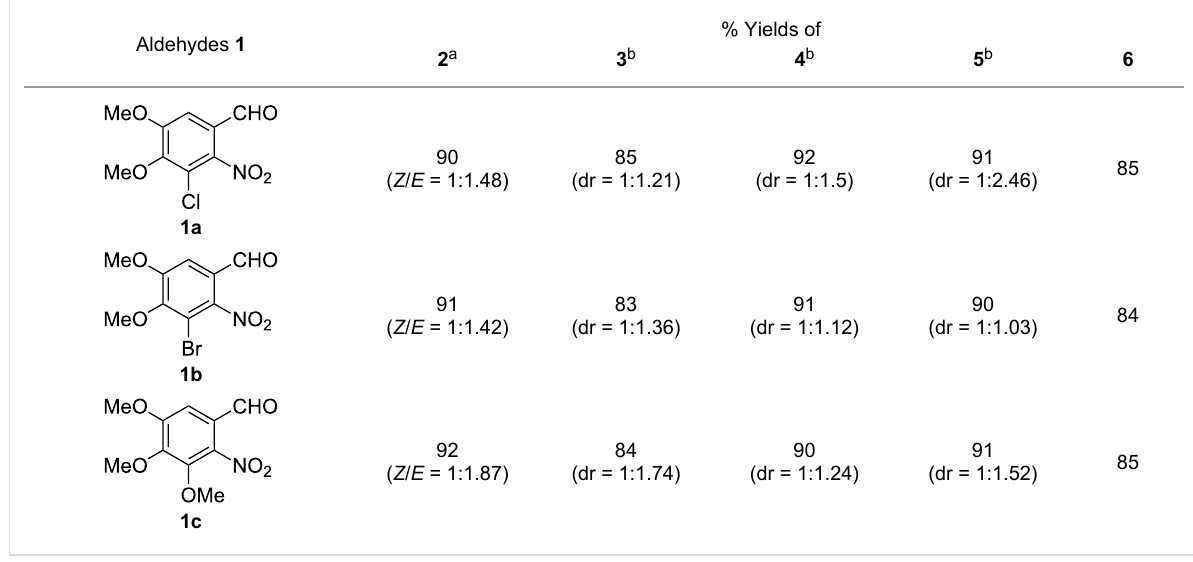
Table 1: Synthesis of